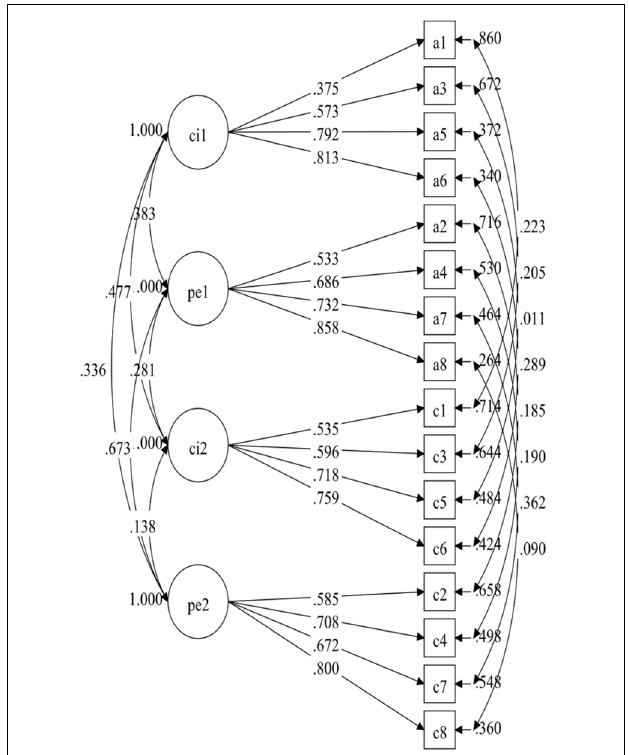
FIGURE 1 | Diagram for the longitudinal configural invariance model. CI-1, consistency of interest at Time 1; PE-1, perseverance of effort at Time 1; CI-2, consistency of interest at Time 2; PE-2, perseverance of effort at Time